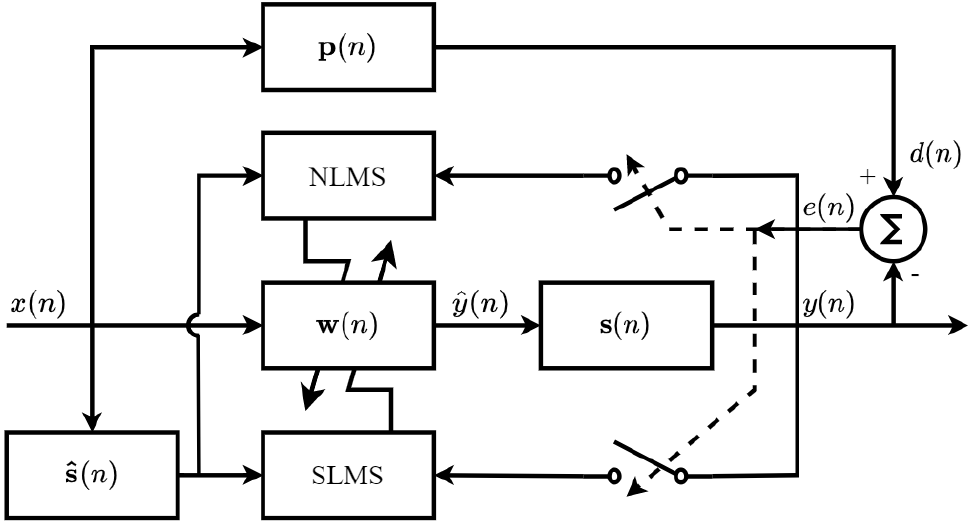
Figure 2. General structure of the proposed filtered-x ANC